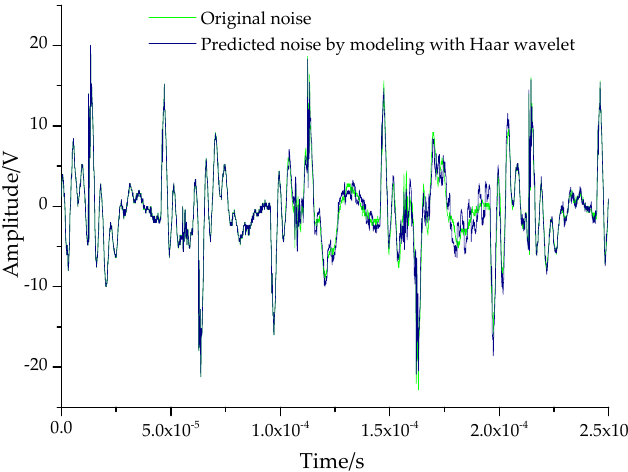
Energies 2019 , 12 , x FOR PEER REVIEW